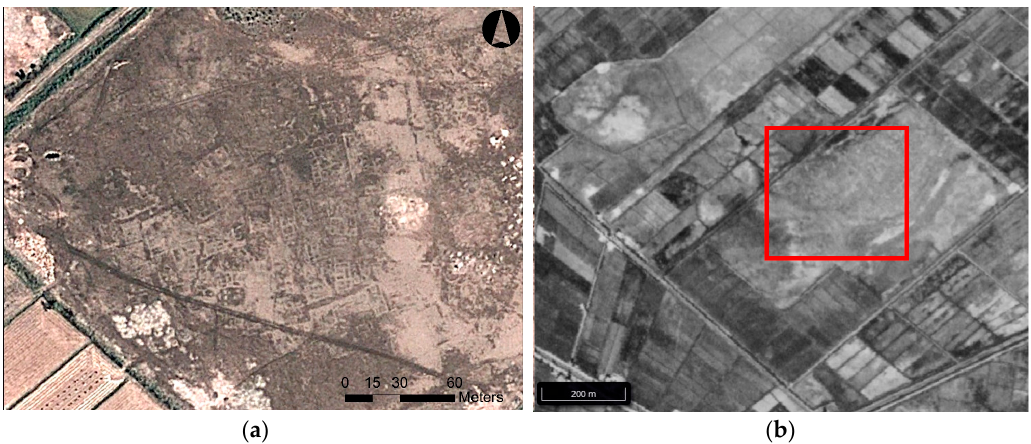
Figure 13. ( a ) The site of Tell el-Arab. Image courtesy Google Earth; ( b ) 1968 CORONA image. Image ( a ) is within the red box. Image courtesy of the Center for Advanced Spatial Technologies, University of Arkansas/U.S. Geological Survey.